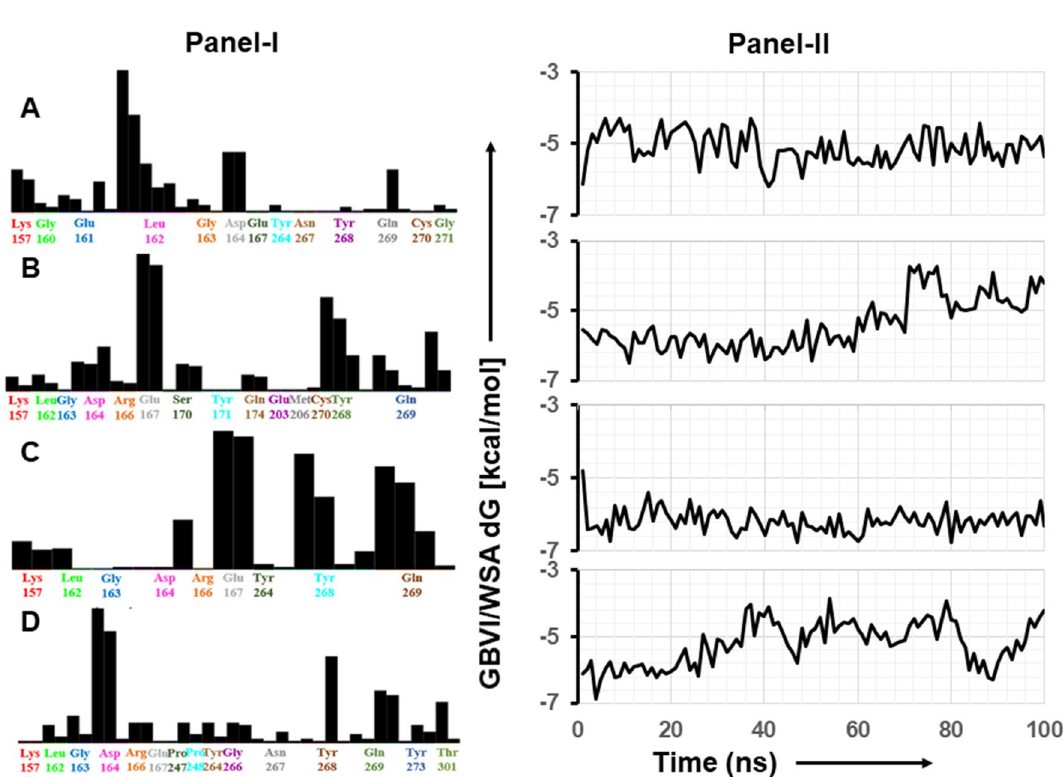
Figure 5. 100ns MD simulation studies of aloin isomers with SARS-CoV-2 PLpro. The Fingerprint region and S-score of the two different orientations of aloin A and B with the SARS-CoV-2 PLpro enzyme. Fingerprinting map (Panel-I) and S-score distribution vs time scale (ns) (Panel-II) for aloin A and B with PLpro. ( A ) Aloin A orientation-1 shows weak interaction with Tyr 268 and strong interaction with Glu 167 . ( B ) Aloin A orientation-2 shows interaction with Tyr 268 , Gln 269 and Glu 167 . ( C ) Aloin B orientation-1 shows strong interaction with Try 268 , Gln 269 , and Glu 167 . ( D ) Aloin B orientation-2 shows strong interaction with Try 268 and Gln 269 but not with Glu 167